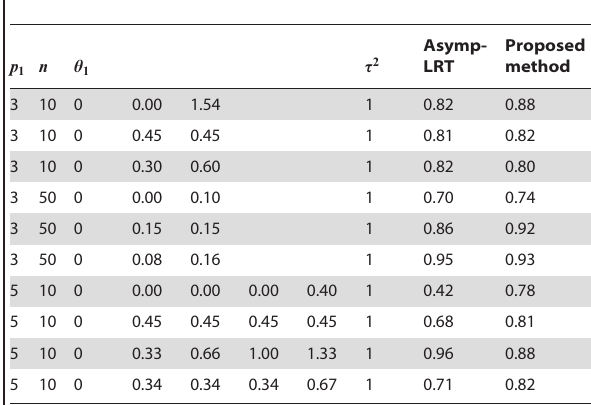
Table 4. Power for heteroscedastic normally distributed data.